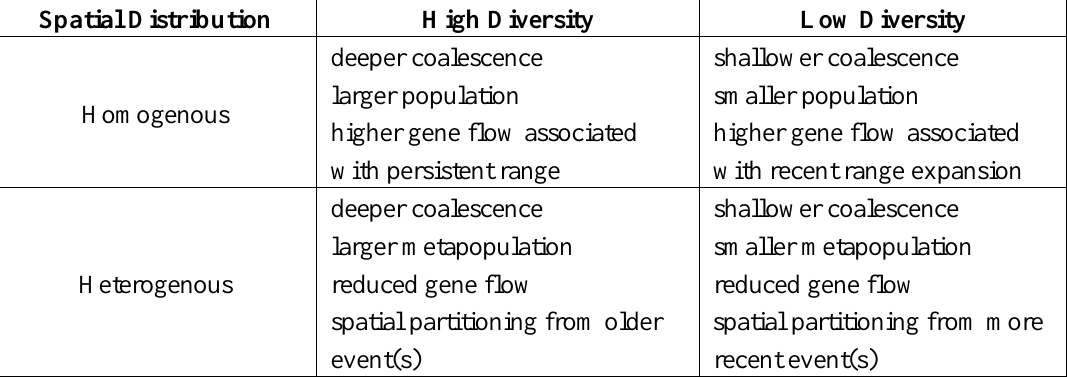
Table 1. Information from phylogeography involves two main parameters: the degree of difference among genetic variants (branch length) and the way this diversity is distributed in